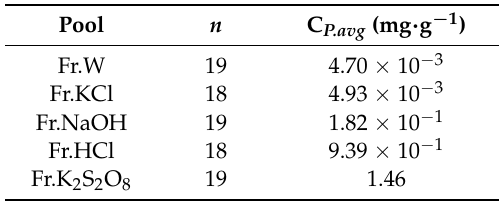
Table 5. Average sediment P concentrations for various fractions. The first two pools tend to be found in much lower concentrations than the other pools, with the organic P (from Fr.K 2 S 2 O 8 ) found in greatest